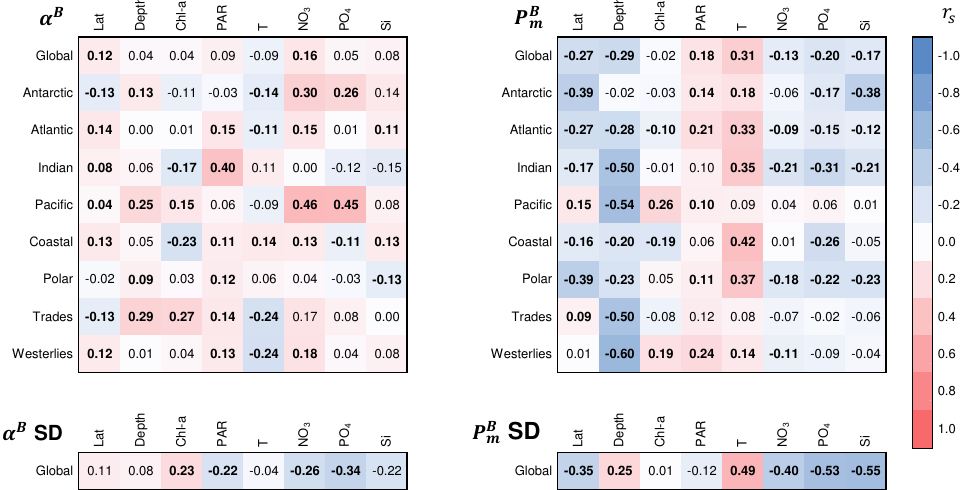
Figure 8. Spearman’s rank correlation coefficients ( r s ) for relationships between the mean and standard deviation (SD) of the initial slope ( α B ) and the assimilation number ( P B m ) of the photosynthesis versus irradiance (P-I) curve and environmental variables available in the P-I database, including absolute latitude (Lat), depth, chlorophyll- a (Chl-a), daily Photosynthetic Active Radiation (PAR), temperature (T), nitrate (NO 3 ), phosphate (PO 4 ) and silicate (Si). Significant relationships ( p < 0.05) are given in